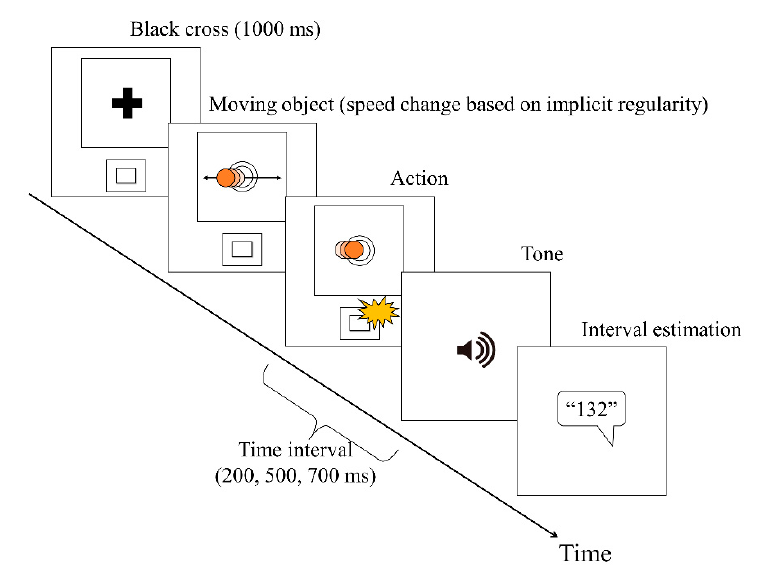
Figure 1. Experimental motor task .